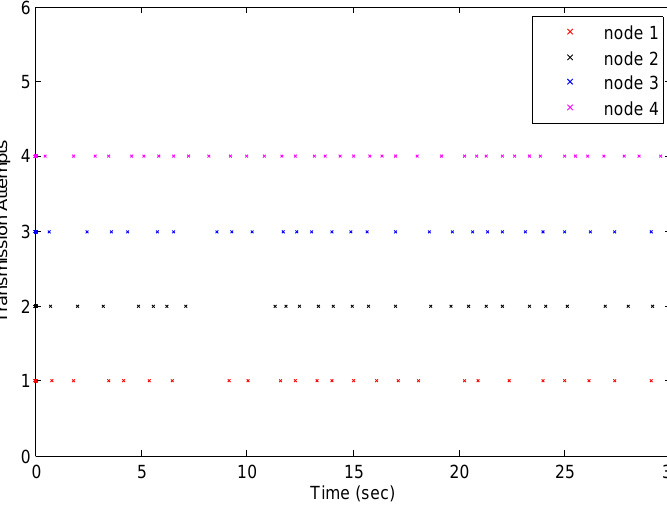
Figure 6. Transmission attempts of follower